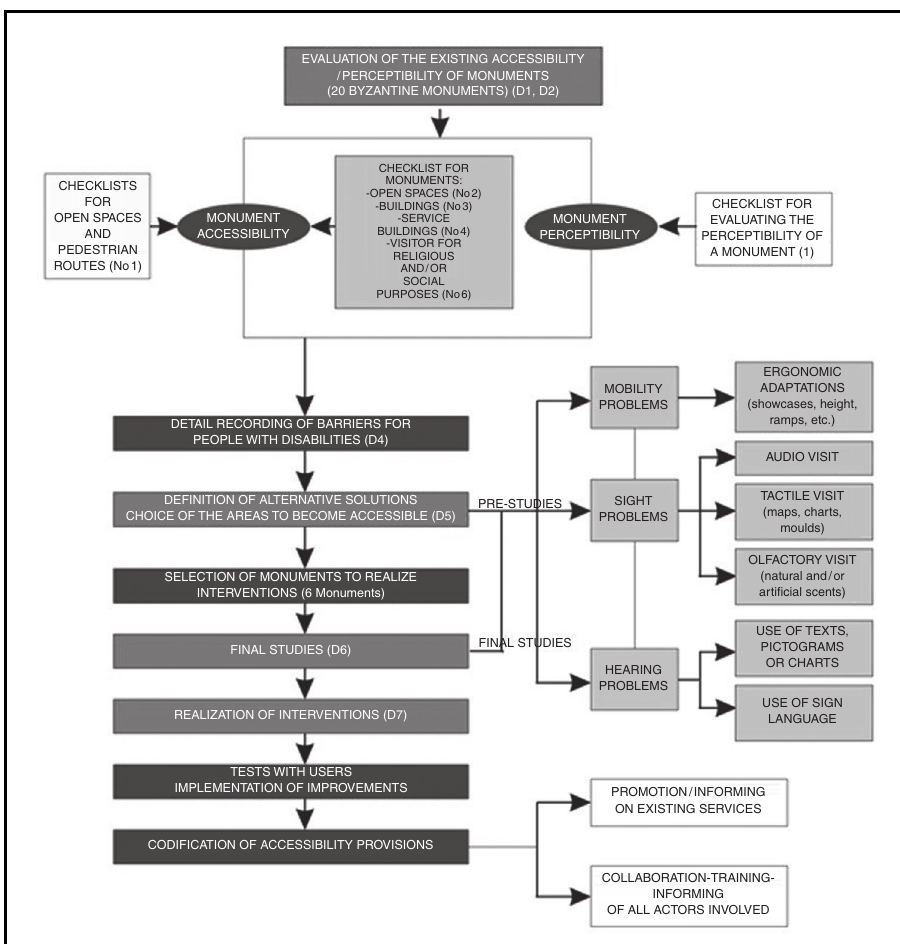
Figure 1 Different components of the methodology